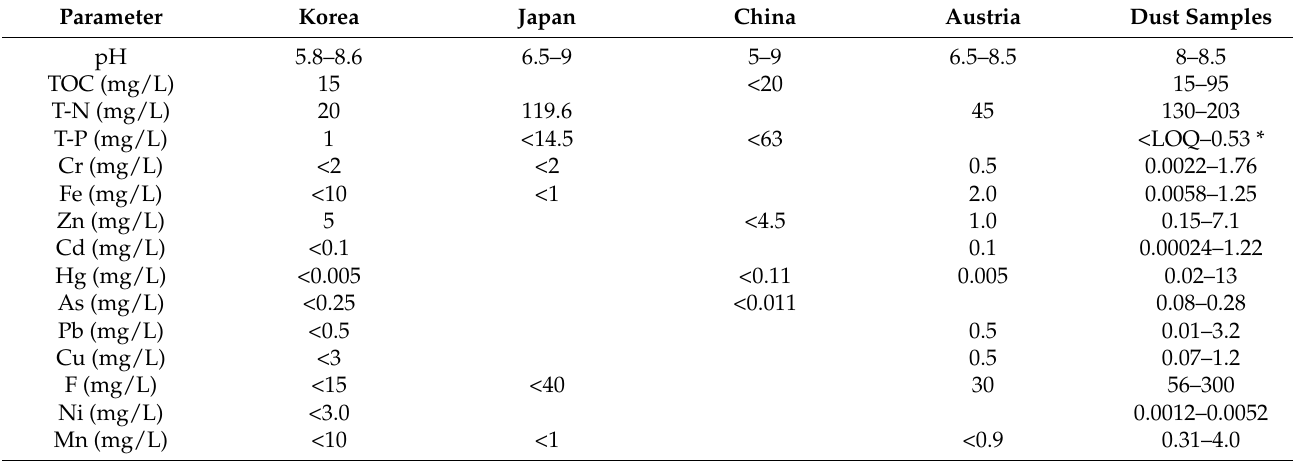
Table 8. Comparison of the emission standards and threshold values with the dust samples. Parameter